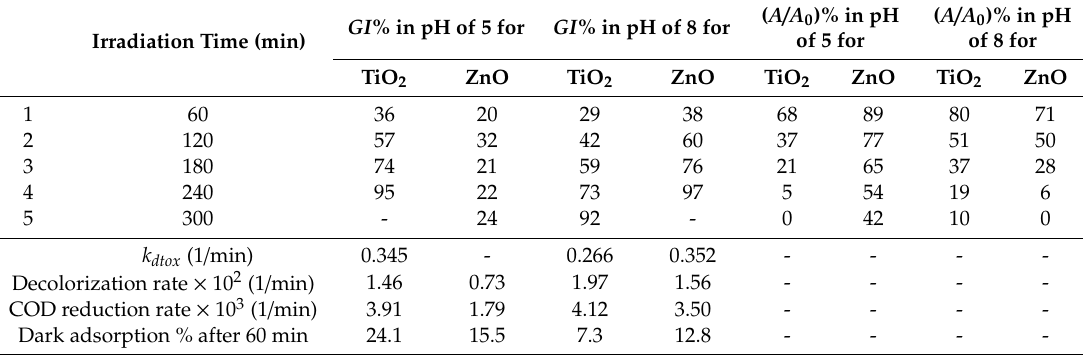
Comparison of photocatalytic performance of two photocatalysts: TiO 2 and ZnO ([FB1] 0 = 50 mg / L, [TiO 2 ] = 0.8 g / L, [ZnO] = 1.2 g / L; and T = 25 ◦ C). Detoxification and dearomatization of FB1 in various irradiation times, as well as decolorization / mineralization and dark surface adsorption of FB1 at two di ff erent pH values of 5 and 8. GI % in pH of 5 for GI % in pH of 8 for Irradiation Time (min)